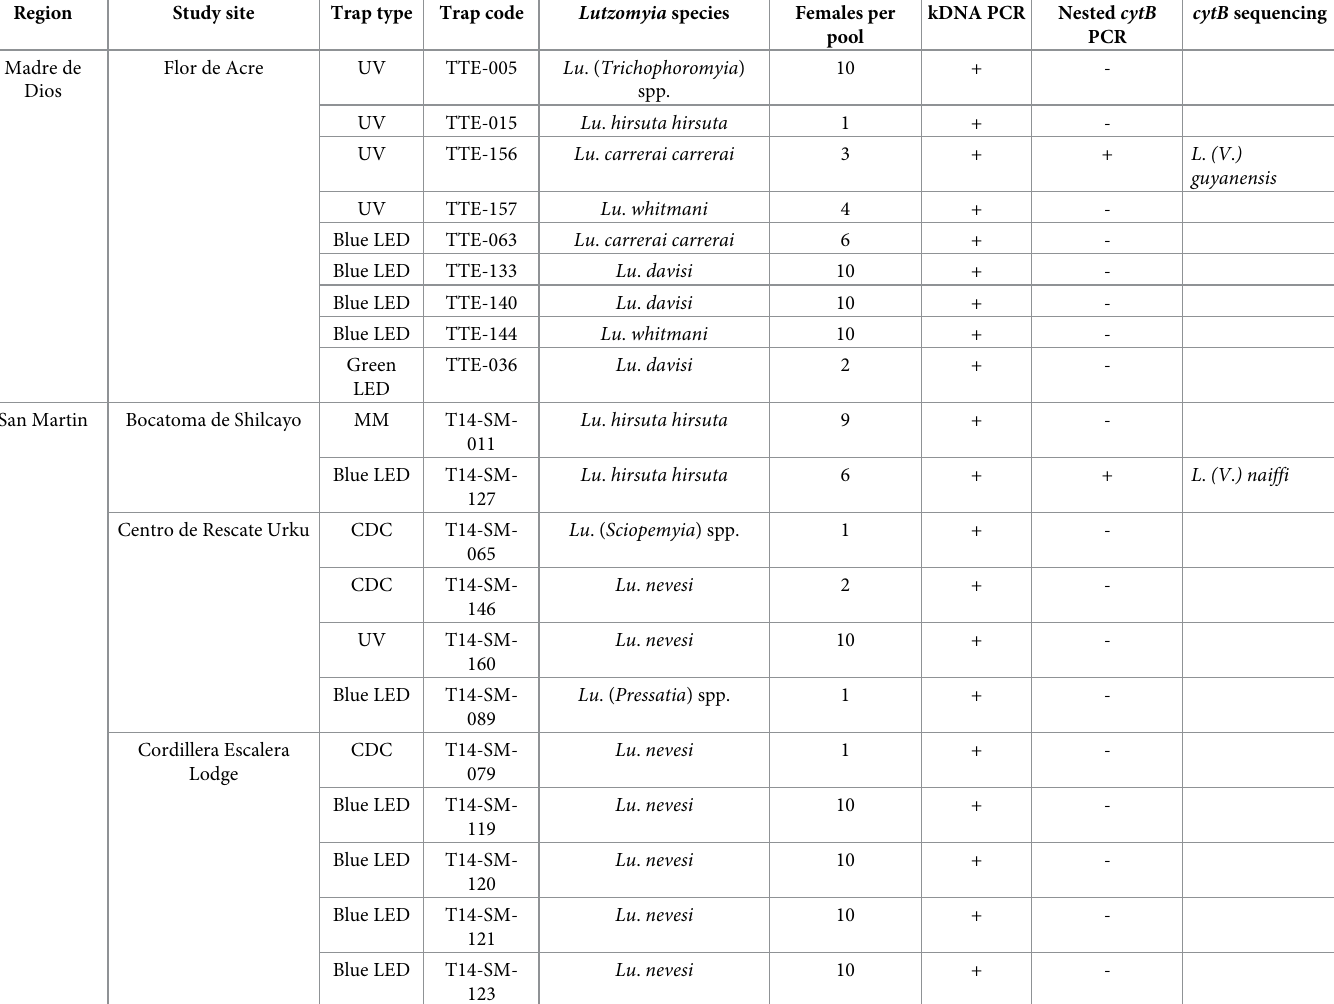
Table 2. Leishmania DNA detection in phlebotomine sand flies from low jungle (Madre de Dios) and high jungle (San Martin) regions in Peru.